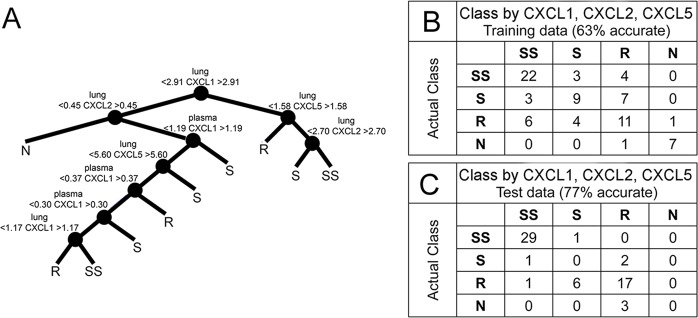
Classification tree based on neutrophil chemokines CXCL1, CXCL2, CXCL5. Female 8-week-old non-sibling DO mice and C57BL/6J mice were infected with ∼100 M. tuberculosis bacilli by aerosol. From the first experiment, complete data for all 15 molecular parameters used for model generation and training were obtained from 70 M.-tuberculosis-infected DO mice and eight non-infected DO mice. The best-performing classification tree used only lung and plasma CXCL1, CXCL2, CXCL5 (A), which was then validated by the leave-one-out method (B). After validation, performance of the classification tree was stringently tested using data from the second independent experiment, which included 52 M.-tuberculosis-infected DO mice, three non-infected DO mice and five M.-tuberculosis-infected C57BL/6J mice (C), with complete data from all 15 molecular parameters.